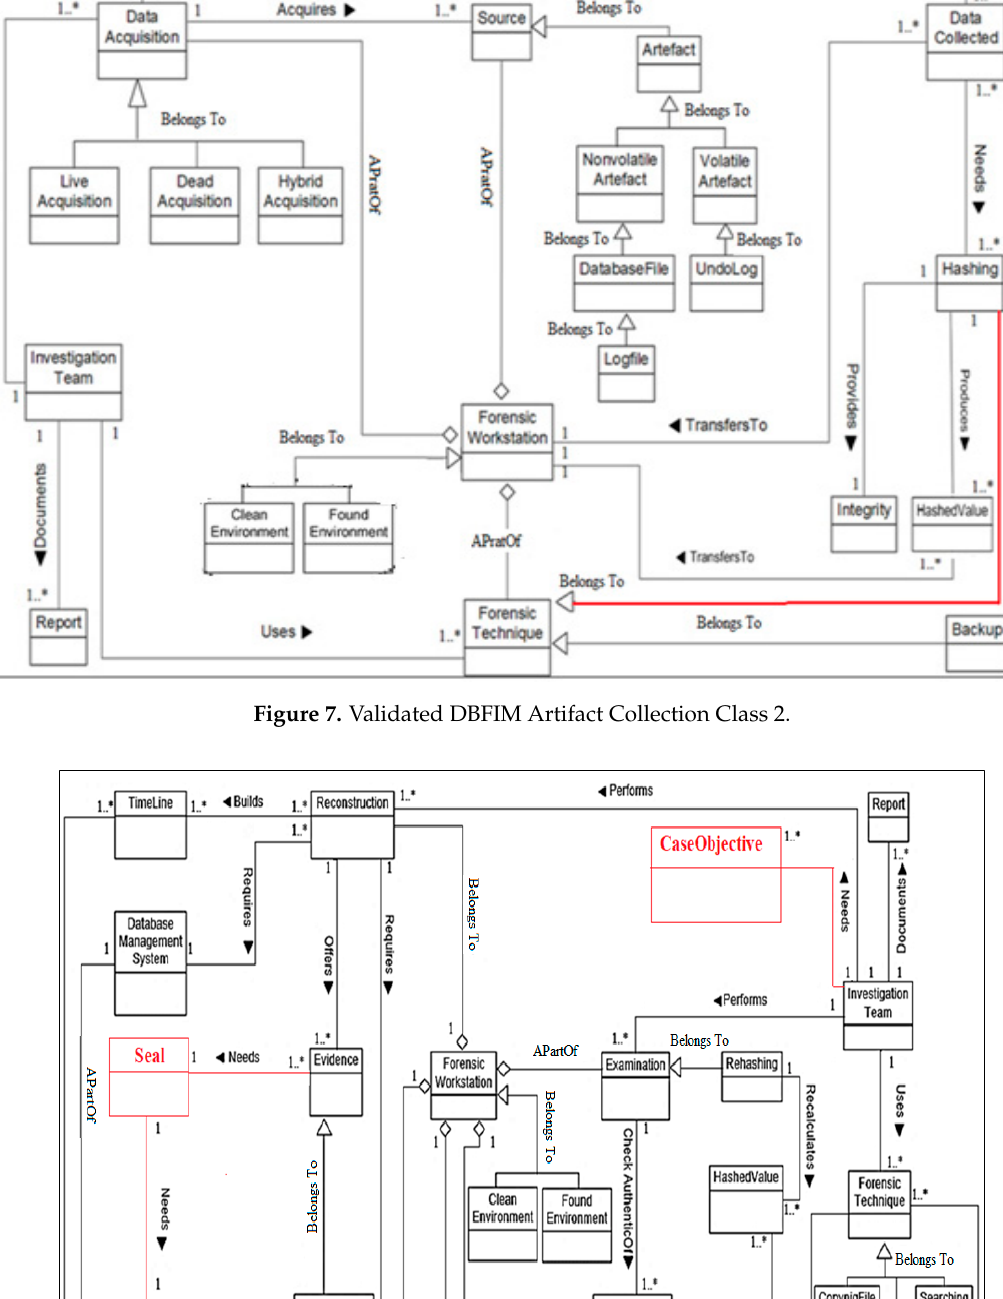
Figure 6. Validated DBFIM Identification Class 1.